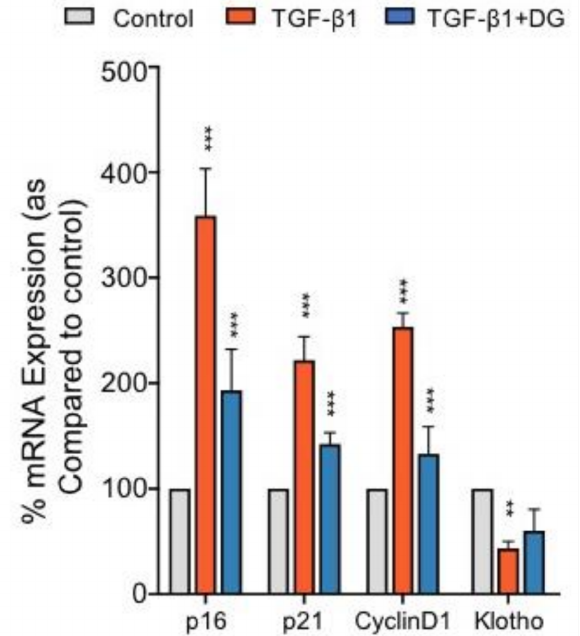
Figure 3. Danegaptide reduces TGF β 1-induced mRNA changes in cell cycle and reno-protective markers. Primary hPTECs were cultured in low glucose (5 mM) ± TGF β 1 (10 ng/mL) ± danegaptide (100 nM) for 12 h. In TGF β 1-treated cells, qPCR analysis demonstrated an increase in p16, p21 and cyclin D1 mRNA and a significant reduction in Klotho mRNA as compared to controls. Danegaptide (100 nM) partly negated the increase in p16, p21 and cyclin D1 and reversed the TGF β 1-evoked change in Klotho. Results are representative of 3 separate experiments and presented as the mean ± SEM ( n = 3), with key significances indicated (** p < 0.01, *** p < 0.001; one-way ANOVA and